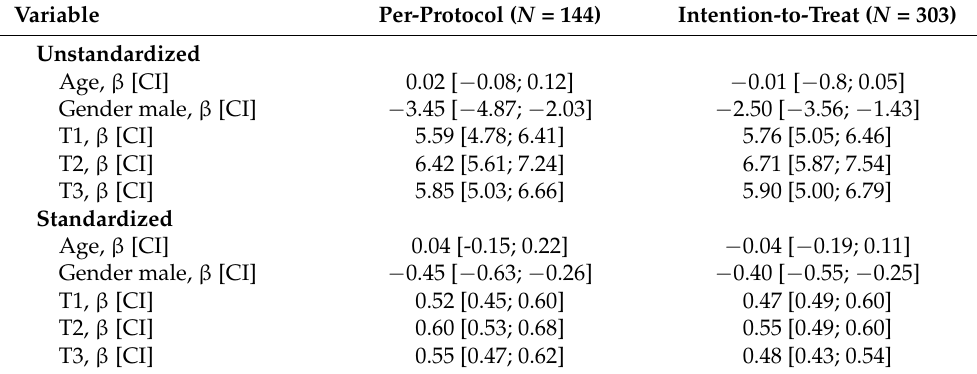
Table A2. Regression coefficients for Model 1, with FL as outcome.